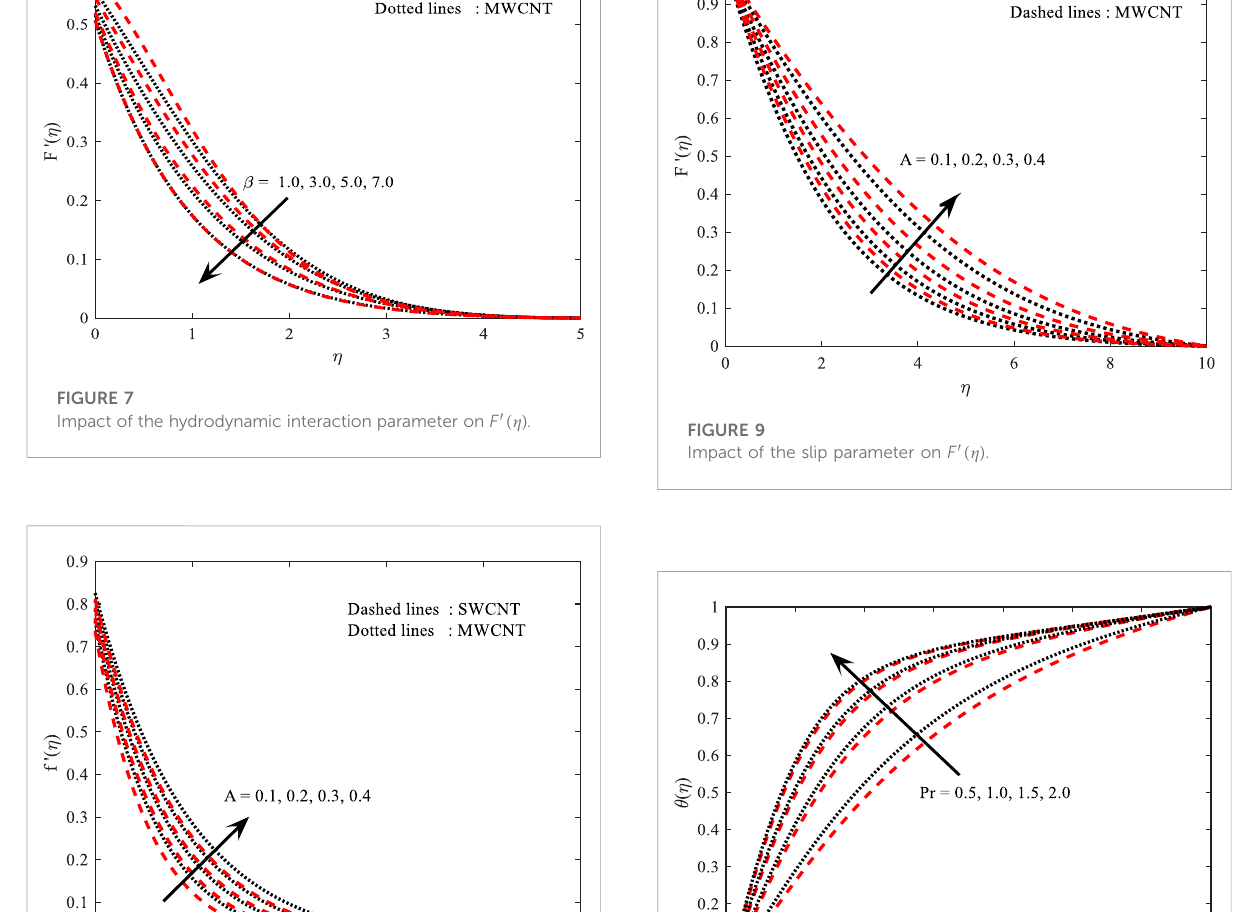
FIGURE 8 Impact of the slip parameter on f ′ ( η ) .